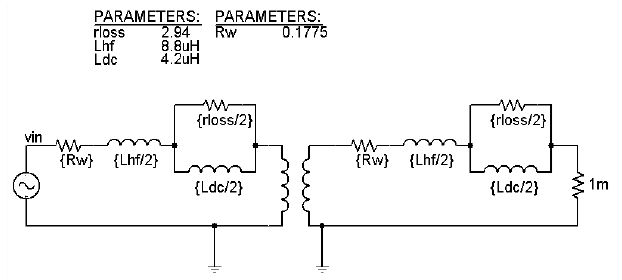
Figure 13: Test Circuit for transformer, including the modified leakage inductance model, implemented in Spice